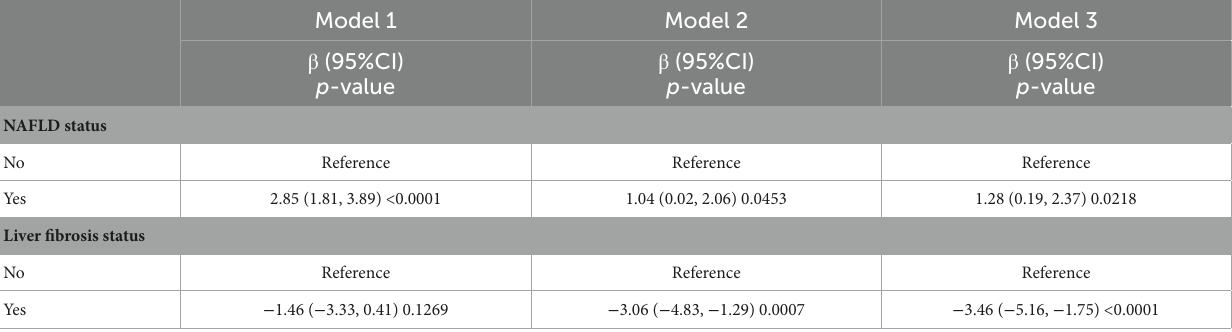
TABLE 2 Relationship between NAFLD or liver fibrosis status and serum retinol ( μ g/dL) in